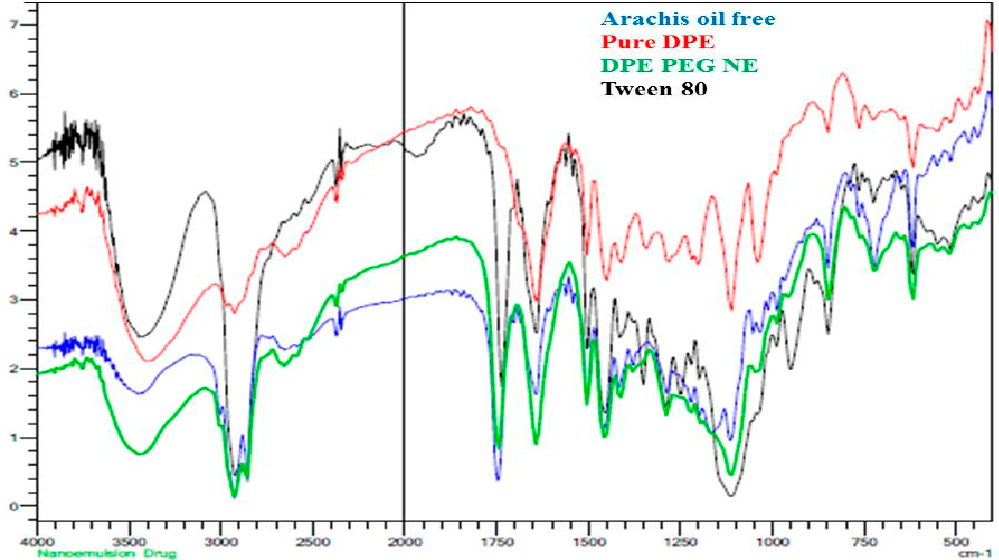
Figure 1. FTIR spectra of pure arachis oil, pure date palm extract (DPE), the developed PEG ‐ nanoemulsion (NE), and tween 80.